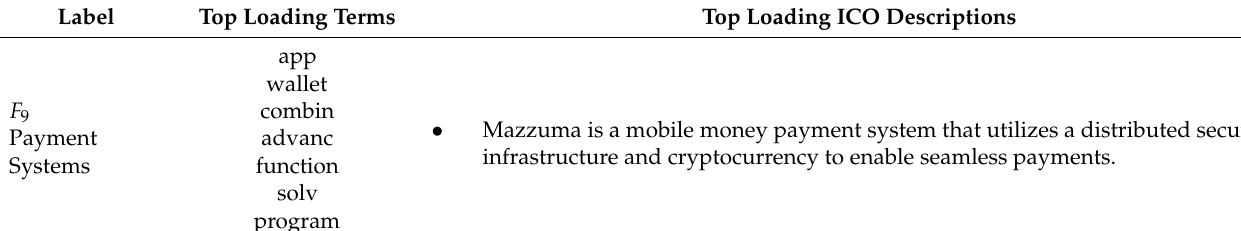
Table A9. Payment systems.